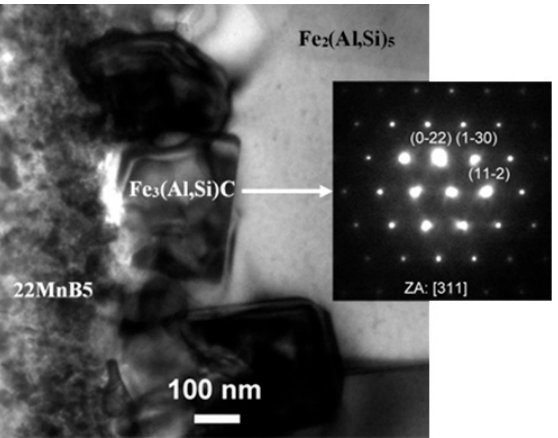
( b ) Figure 10. TEM micrographs of ( a ) the coating layer composed of Fe 2 Al 5 and ( b ) detail of the Fe 2 Al 5 layer, showing a cuboid-like Fe 2 (Al,Si) 5 particle. Further away, the coating changed its composition again, and this layer had the same chemical composition and crystallographic structure as the innermost Fe 2 (Al,Si) 5 layer, which was followed by a thin layer of Fe 2 Al 5 . This latter layer was followed by the outer- most coating layer with a chemical composition of Fe 2 Al 8 Si. This was indeed a fairly scat- tered layer with a nonuniform thickness. Figure 11 shows a representative image of the interface between Fe 2 Al 5 and Fe 2 Al 8 Si. SAEDPs were recorded and are also reported in Figure 11 insets. The Fe 2 Al 8 Si ternary phase is a major reaction product formed at the in- terface of the steel and Al-Si hot-dipped coating, as well as partly dispersed in the Al-Si coating matrix. The presence of this ternary phase in the outermost coating layer can be explained by the gradual enrichment of the coating with Fe and vice versa by the diffusion of Al and Si into the steel substrate. As a result of this Fe enrichment, the ternary phase was shifted towards the coating surface, where it formed a discontinuous layer due to its partial conversion to the Fe richer phases. Windmann et al. [17] reported the occurrence of Fe 2 Al 8 Si after 1 min of austenitization at 920 °C, and its transformation to an iron-richer phase of type Fe 2 Al 5 with increasing dwell time. However, the Fe 2 Al 8 Si ternary phase was clearly identified in the coating, even after an 8 min dwell time at 920 °C in the present study.